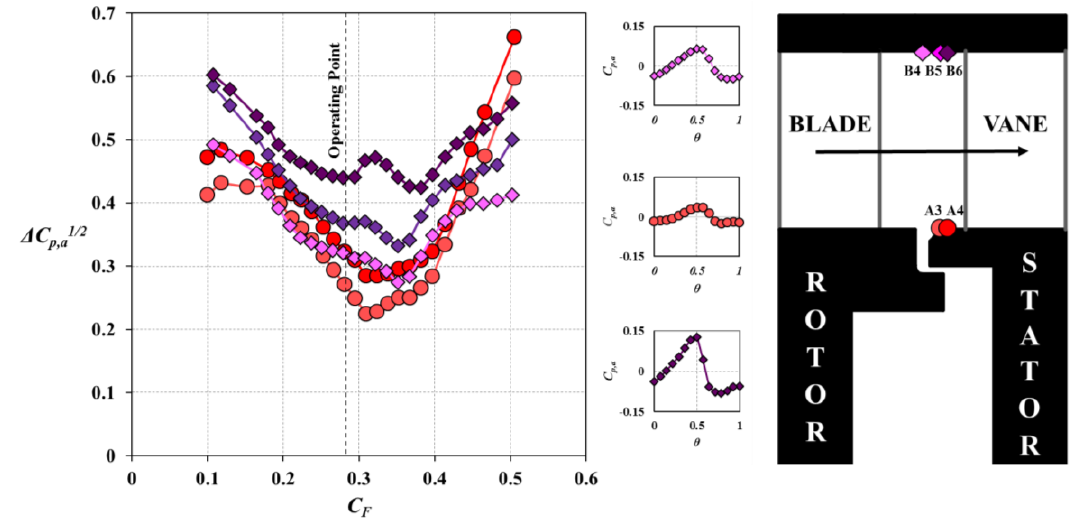
Figure 7. Variation of Δ C p,a 1/2 with flow coefficient C F in the annulus downstream of the rotor blades and selected circumferential distributions of non-dimensional pressure coefficient C p,a at the operating point ( Re φ = 7.2 × 10 5 , Φ 0 = 0).